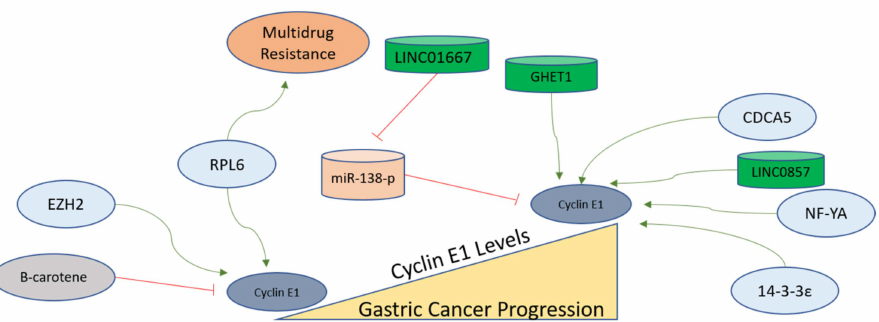
Figure 5. Cyclin E1 regulation in gastric cancer progression. Cyclin E functions to progress cells from G1 to the S phase and remains upregulated in the S phase. In gastric tumors, Cyclin E1 expression is higher than in normal tissues. The factors activating the functions of Cyclin E in gastric cells are shown, with green arrows indicating activation and red lines showing inhibition. The mechanisms of these regulators are described in detail in the main